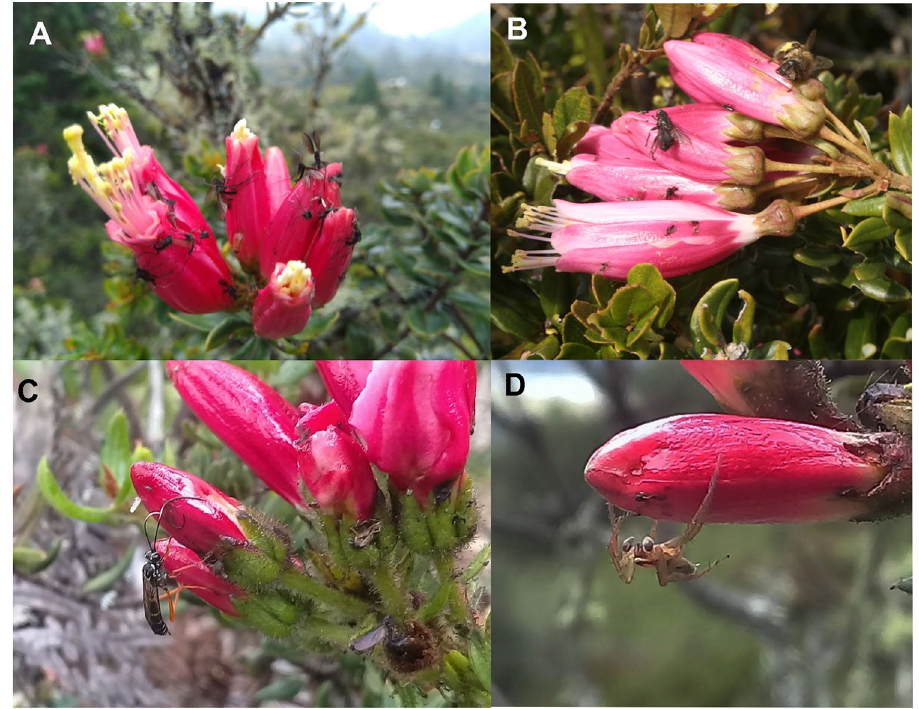
Figure 1. Insects caught on sticky flowers of Bejaria resinosa. ( A ) Multiple flies, ( B ) Bee, ( C ) Wasp, ( D )